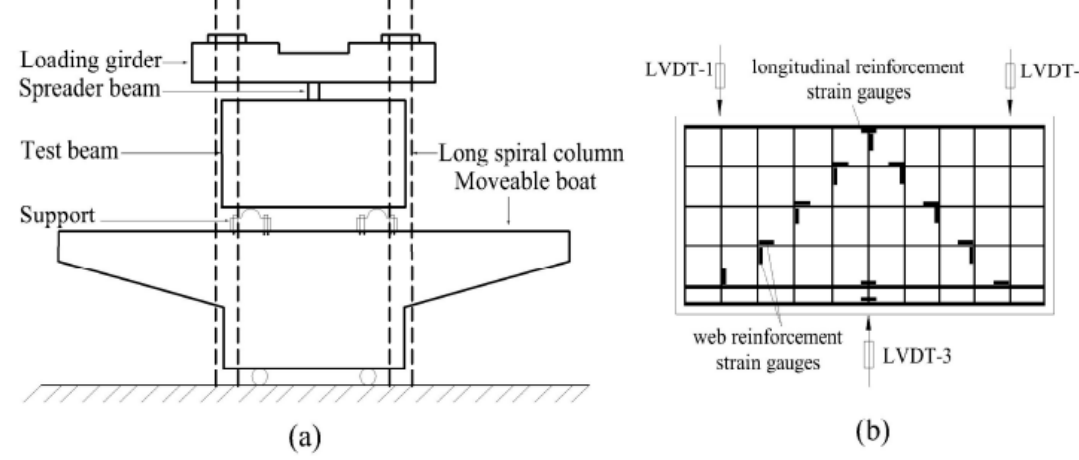
Figure 7. Instrument of test ( a ) setup; ( b ) strain gauges and LVDTs arrangement.